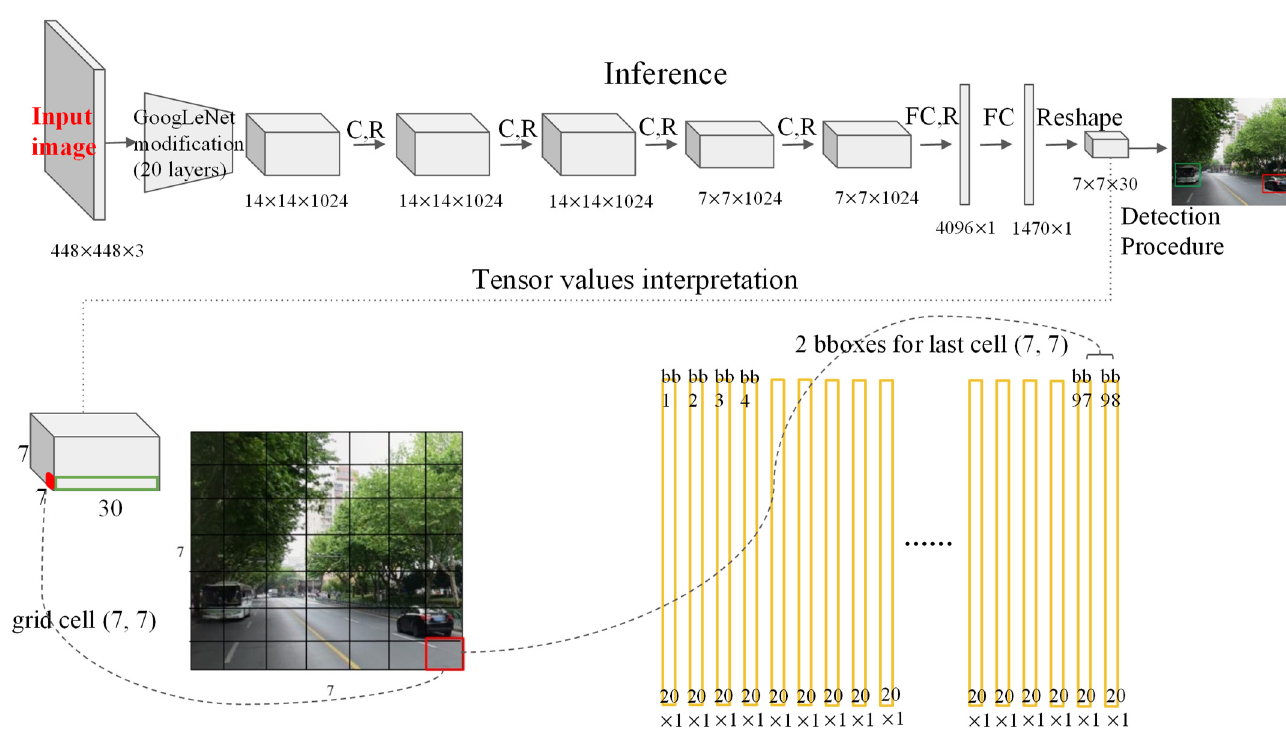
Figure 2. YOLO network structure.